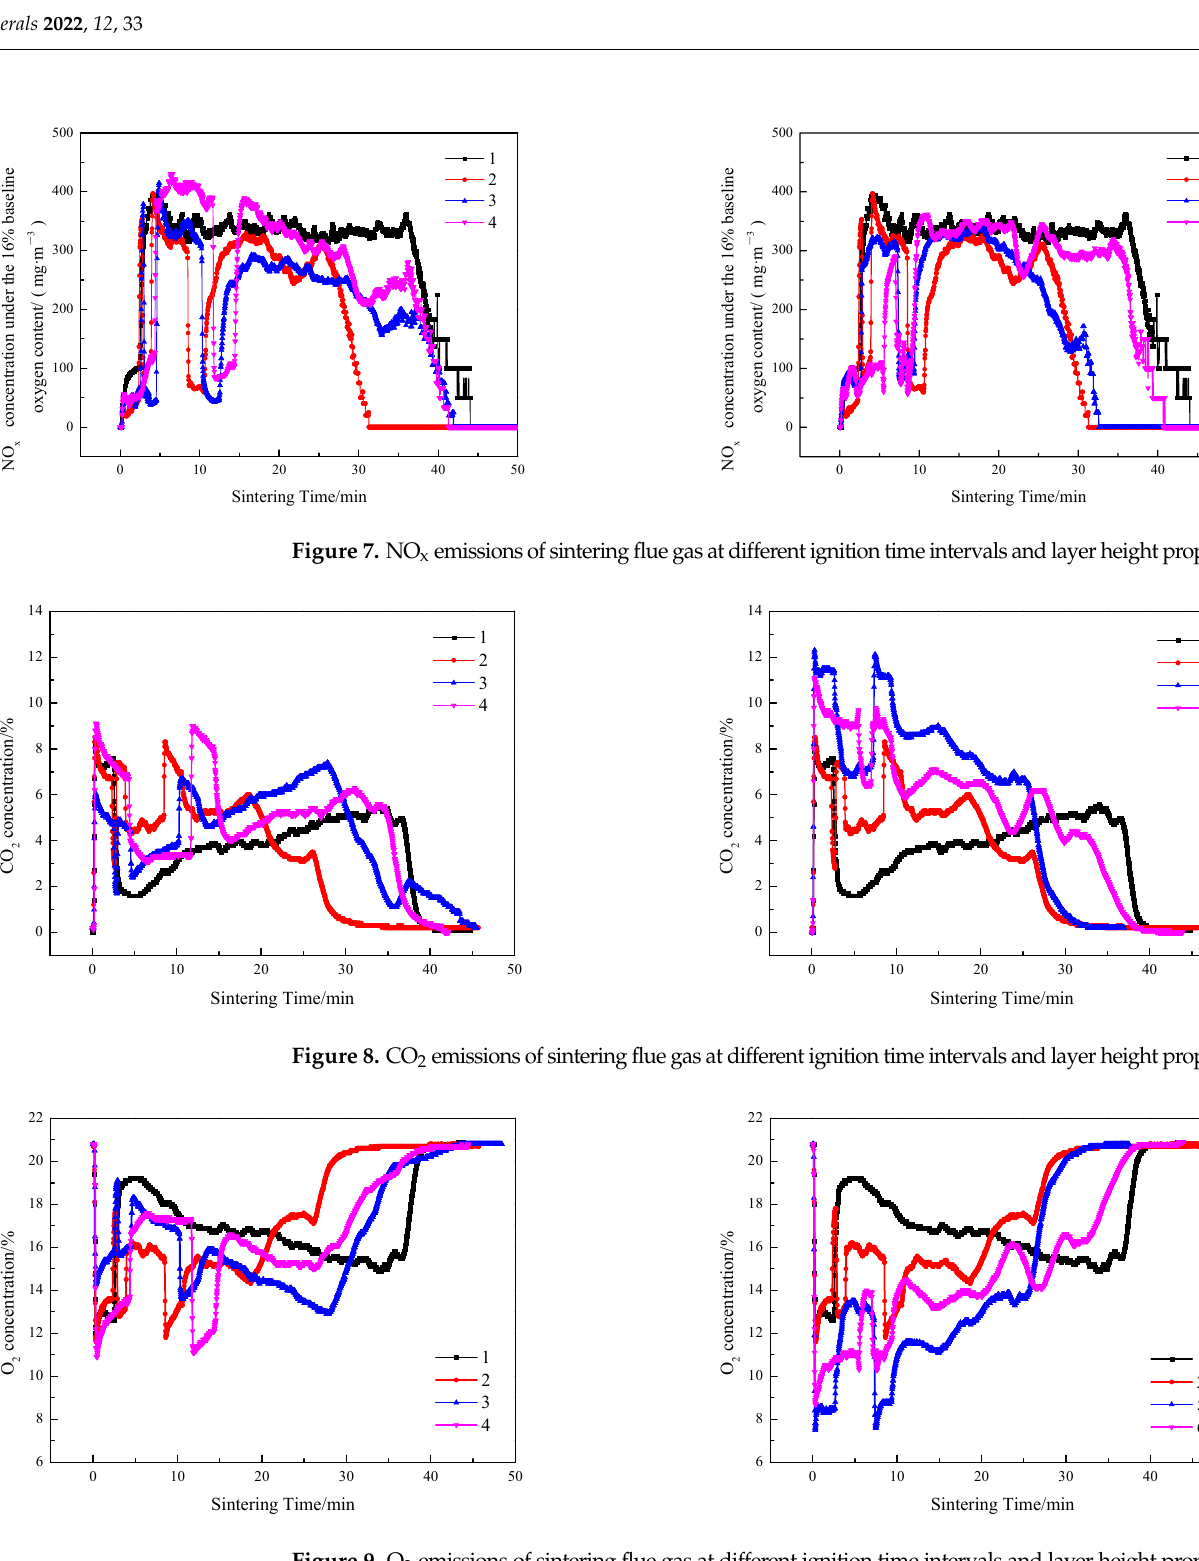
Figure 9. O 2 emissions of sintering flue gas at different ignition time intervals and layer height pro- portions.